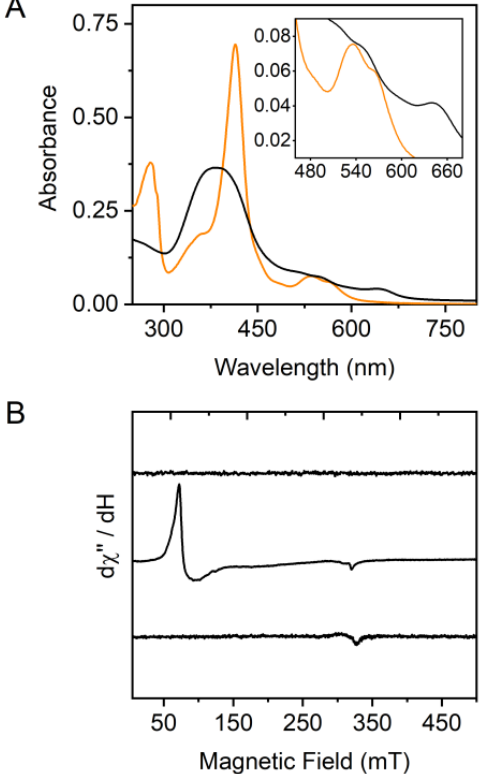
Figure 1. UV–vis and EPR spectra of HupZ in complex with ferric heme. ( A ) UV–vis spectra of 6 µ M Figure 1. UV – vis and EPR spectra of HupZ in complex with ferric heme. ( A ) UV – vis spectra of 6 HupZ-heme (orange trace) compared to 6 µ M free heme (black). ( B ) EPR spectra of 200 µ M HupZ μM HupZ - heme (orange trace) compared to 6 μM free heme (black). ( B ) EPR spectra of 200 μM (top trace), 250 µ M free ferric heme (middle trace), and 200 µ M HupZ-heme complex (bottom HupZ (top trace), 250 μM free ferric heme (middle trace), and 200 μM Hu pZ-heme complex (bot- tom trace).